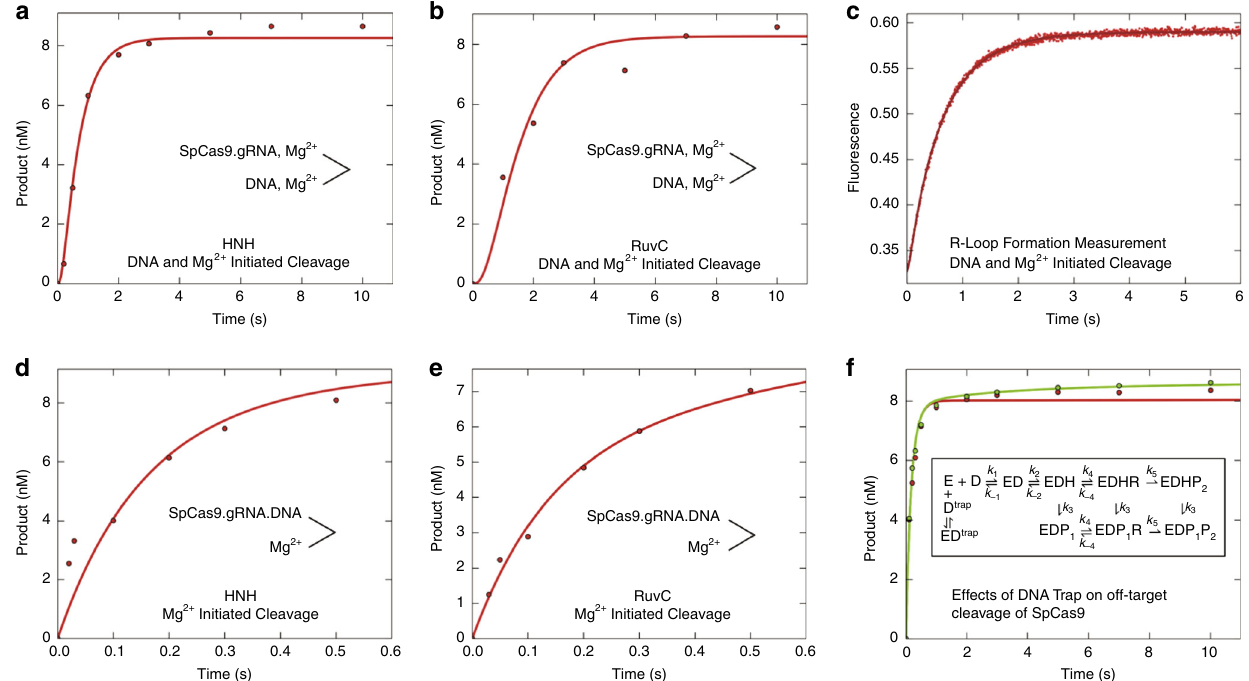
Fig. 5 Global fi tting of experiments performed to interrogate on-target activity of SpCas9. a DNA and Mg 2 + initiated cleavage by the HNH domain. b DNA and Mg 2 + initiated cleavage by the RuvC domain. c R-loop formation rate. d Mg 2 + initiated cleavage by the HNH domain. e Mg 2 + initiated cleavage by the RuvC domain. f Effect of DNA trap on kinetic partitioning of Cas9 cleavage. All curves were calculated based on the global fi t to the data according to the kinetic model (inset), with rate constants shown in Table 1. Error estimates were based on con fi dence contour analysis as shown in Fig. 6. E is Cas9. gRNA, D is target DNA, ED is Cas9.gRNA.DNA, EDH is R-loop formation with docking of target strand to HNH, EDHR and EDP 1 R are R-loop formation with docking of non-target strand to RuvC, EDHP 2 is RuvC cleavage of non-target strand, EDP 1 is HNH cleavage of the target-strand, EDP 1 P 2 is cleavage of both strands, D trap is excess unlabeled, perfect-matched DNA. ED trap is Cas9.gRNA.DNA trap